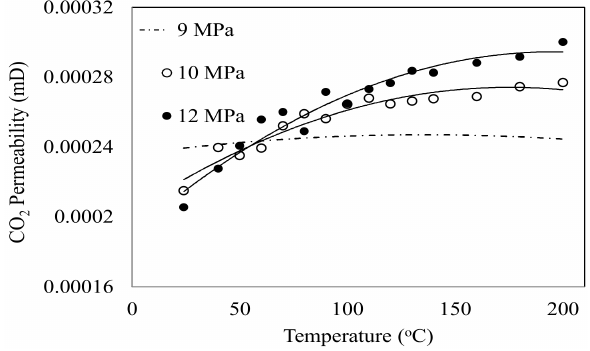
Figure 13. Influence of temperature on CO 2 flow ability in bituminous coal for various CO 2 pressures